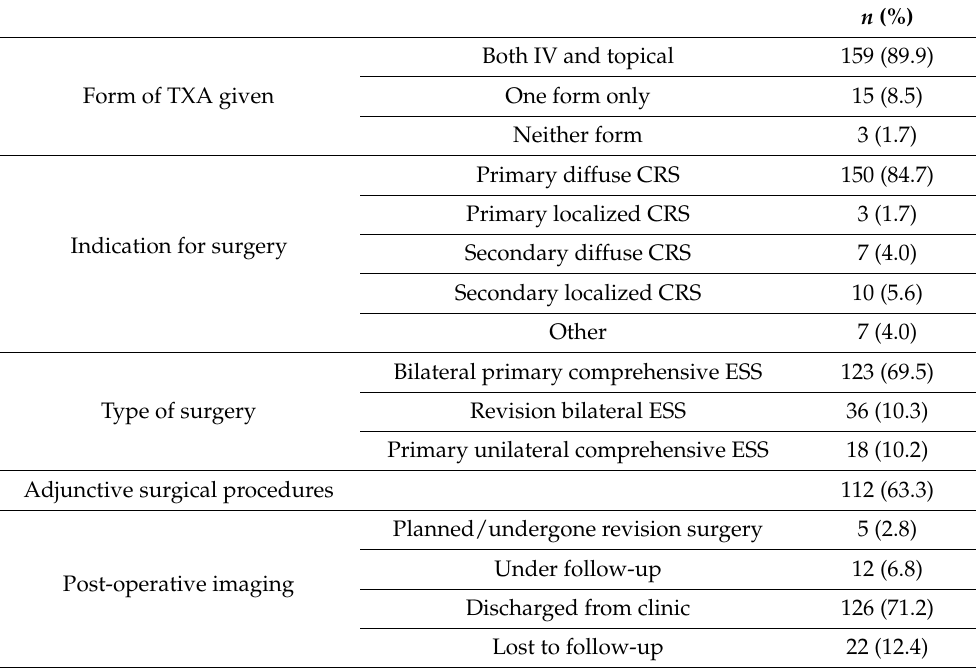
Table 2. Patient and surgical characteristics: retrospective clinical